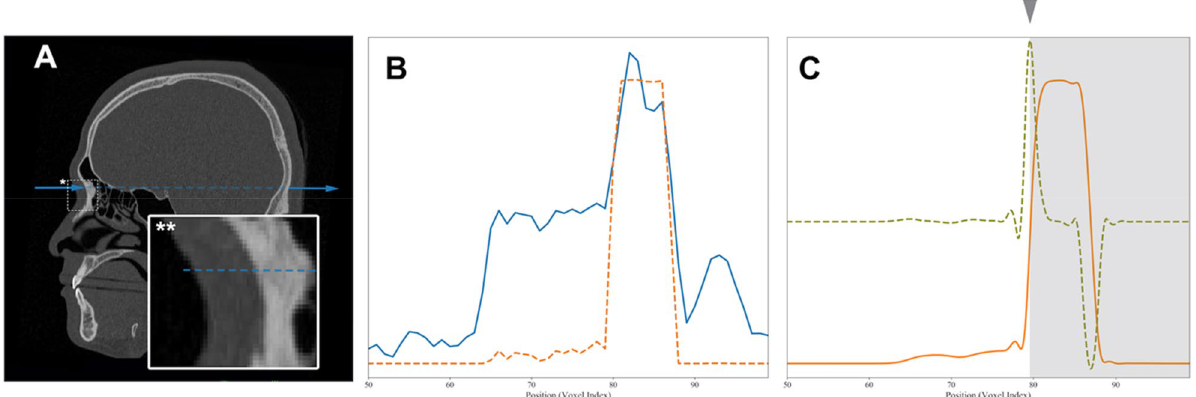
Figure 5. Gradient-based boundary estimation for single-stage DRL. ( A ) A sectional CT image in the sagittal plane with a radiographic beam-mimic line (blue dashed line) passing through a sampled landmark, nasion and surrounding box with asterisk (*). The view of the box region is magnified in the inset box at the left bottom with double asterisks (**) and the y-directional line (blue solid). ( B ) One-dimensional plot of image density profile in Hounsfield units, shown as a blue solid line along the y-directional line passing through the air, through nasion, and the soft and bone tissue, indicated by the blue dashed line in Fig. A. The orange dashed line indicates the bone intensity-enhanced profile. ( C ) Plot of the same source for B showing the non-linear diffusion profile of the bone intensity-enhanced one (orange solid line), its first order derivative profile (light green dashed line), and the final boundary estimation of bone (marked by arrowhead and gray